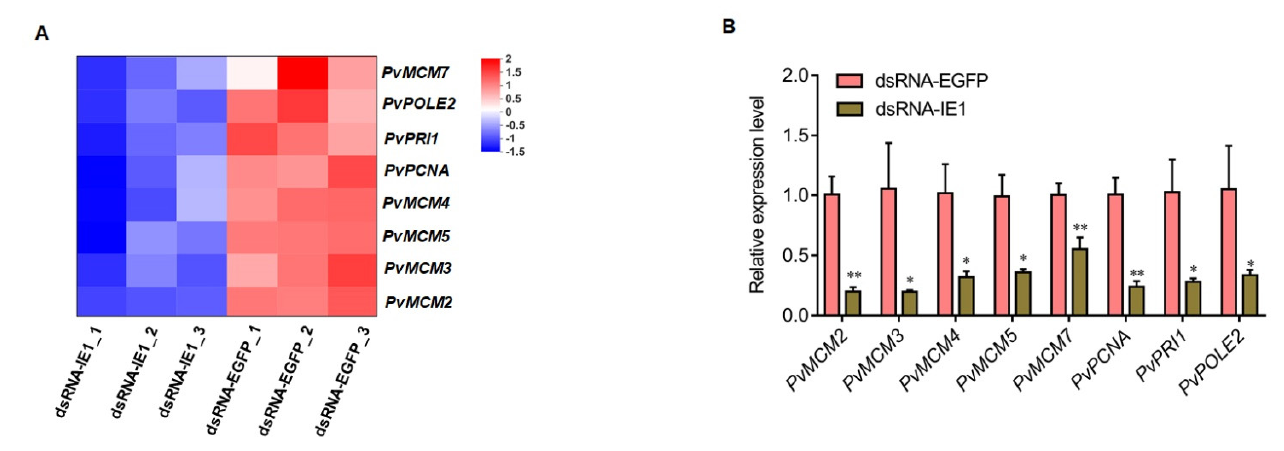
Figure 5. Validation of DEGs by qPCR analysis. ( A ) Heatmap of the DNA-replication-related DEGs in transcriptome sequencing data. ( B ) qPCR validation analysis of the DEGs. The data were shown as mean ± SD, and the statistical significance was determined by Student’s t -test (* indicates p < 0.05; and ** indicates p < 0.01).